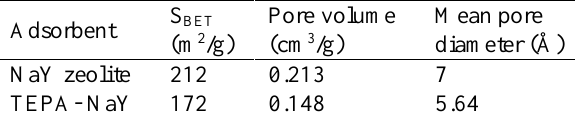
Fig. 6. N 2 adsorption-desorption isotherms of NaY (1) and TEPA- NaY (2) powders at 77 K Table 2. Structural properties of NaY and TEPA-